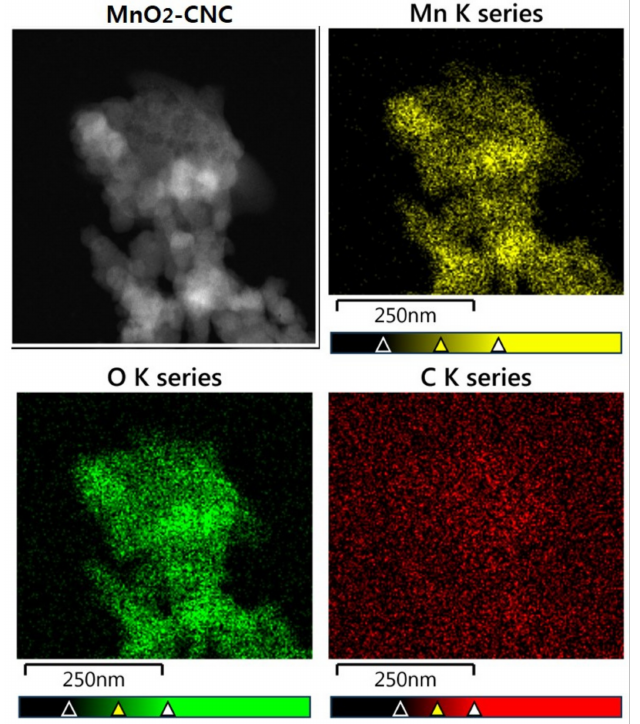
Figure 7. TEM elemental mapping of the MnO 2 -CNC